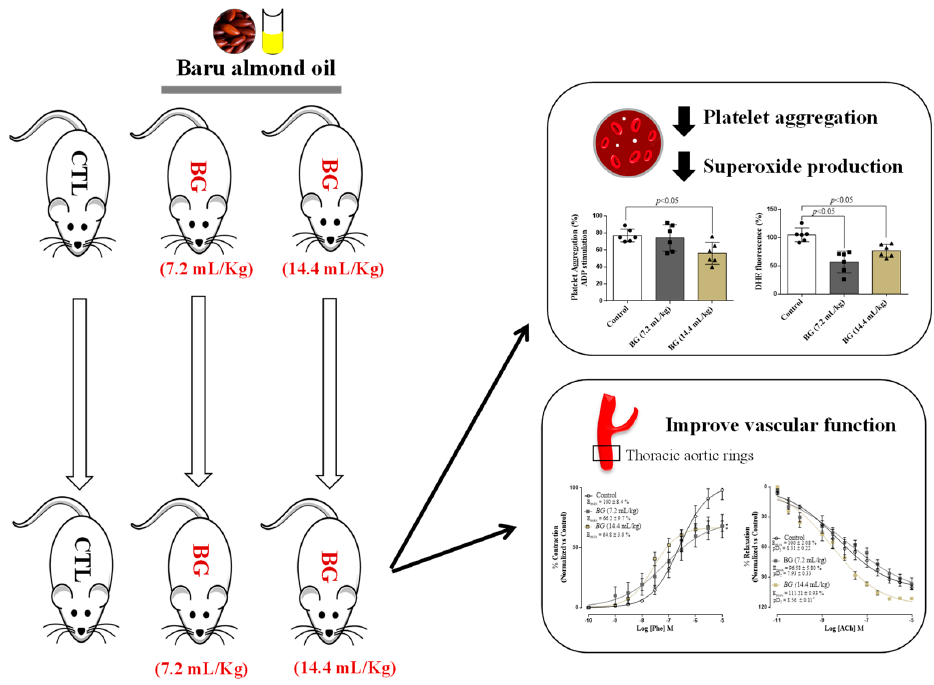
Figure 5. Schematic drawing showing the effect of the Baru almond oil administration on platelet aggregation, superoxide anion generation, and vascular function in rats. CTL (control), BG (Baru group). Supplementary Materials: The following are available online at https://www.mdpi.com/article/ 10.3390/nu14102098/s1, Figure S1. Typical chromatogram of the separation of tocopherols in Baru